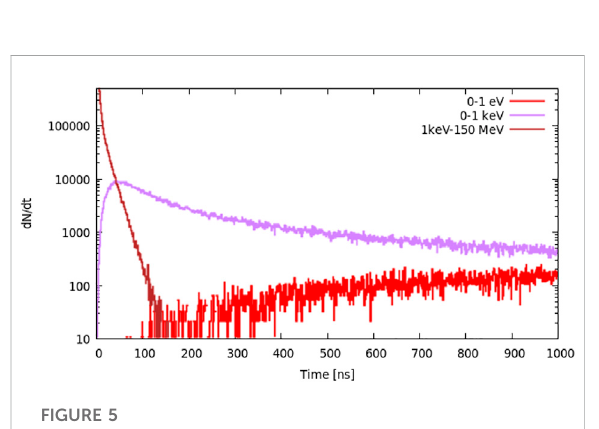
FIGURE 5 Neutron distribution in the layer where R = 2 cm; there are two slow neutron energy groups: 0 – 1 eV and 0 – 1 keV and one fast neutron group: 1 keV – 150 MeV.